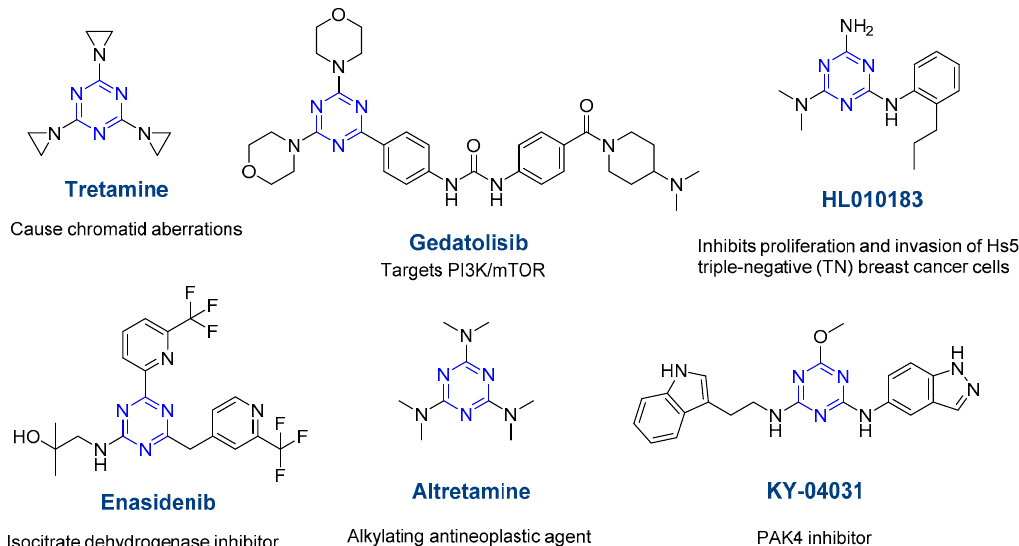
Figure 2. Some commercial drugs bearing the s-triazine